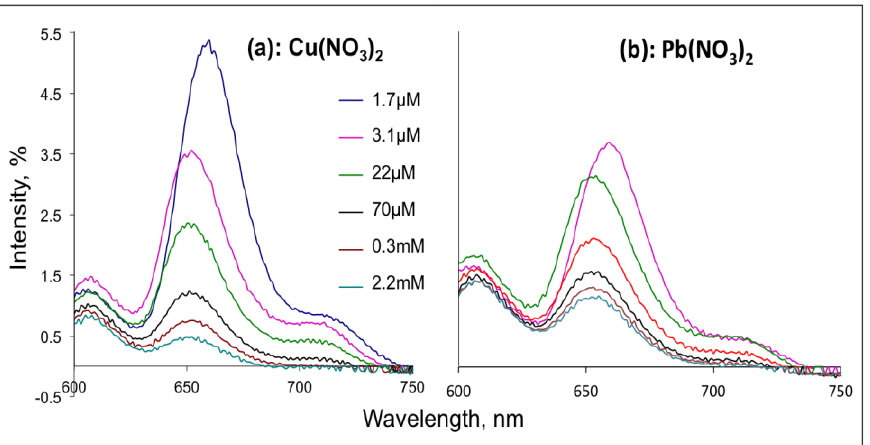
Figure 2. The fluorescence quenching of H ( a ) Cu 2+ and ( b ) Pb 2+